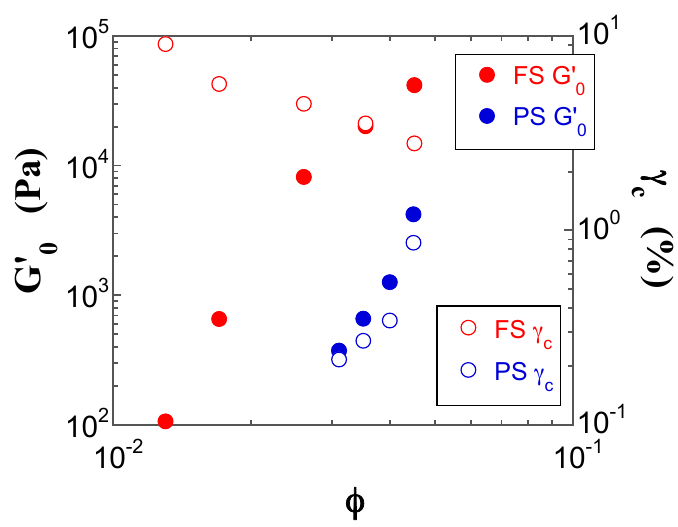
Figure 10. Double-logarithmic plots of the G ′ value in the linear region ( G' 0 , filled circles) and the critical oscillatory shear strain ( γ c , open circles) for the FS (red) and PS (blue) suspensions as a function of φ .